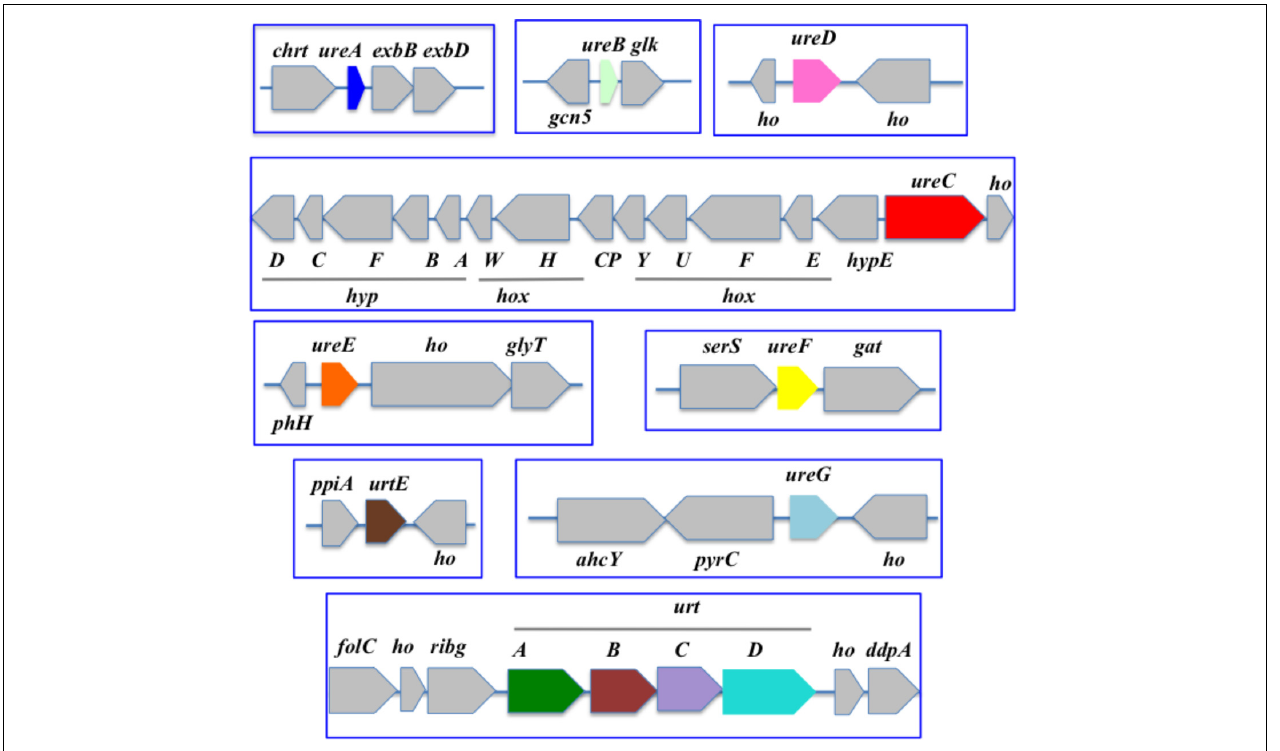
FIGURE 4 | Organization of the urea acquisition and catabolism genes in Synechococcus PCC 7002. The genes are shown as colored boxes pointing in the direction of their transcription. Gray boxes correspond to genes not known to be involved in urea metabolism or transport. ahcY, adenosyl homocysteinase ; chrt , chromate transport; ddpA, peptide ABC transporter substrate binding protein; exbB and exbD , biopolymer transport; folC , folypolyglytamte; gat , glutamine amidotransferase. gcn5 , N-acetyltransferase GCN5; glk , glucokinase; glyT , glycosyl transferase; ho , hypothetical protein; hoxEFGHU , Ni-Fe hydrogenase subunits; hoxW , HoxH-specific protease; hypABCDEF , Ni-Fe hydrogenase chaperone subunits; phh, phosphohydrolase; ppia, peptidylprolyl isomerase A; pyrC, dihydroorotase ; ribg , ADP-ribosylglycohydrolase; serS , serine-tRNA ligase